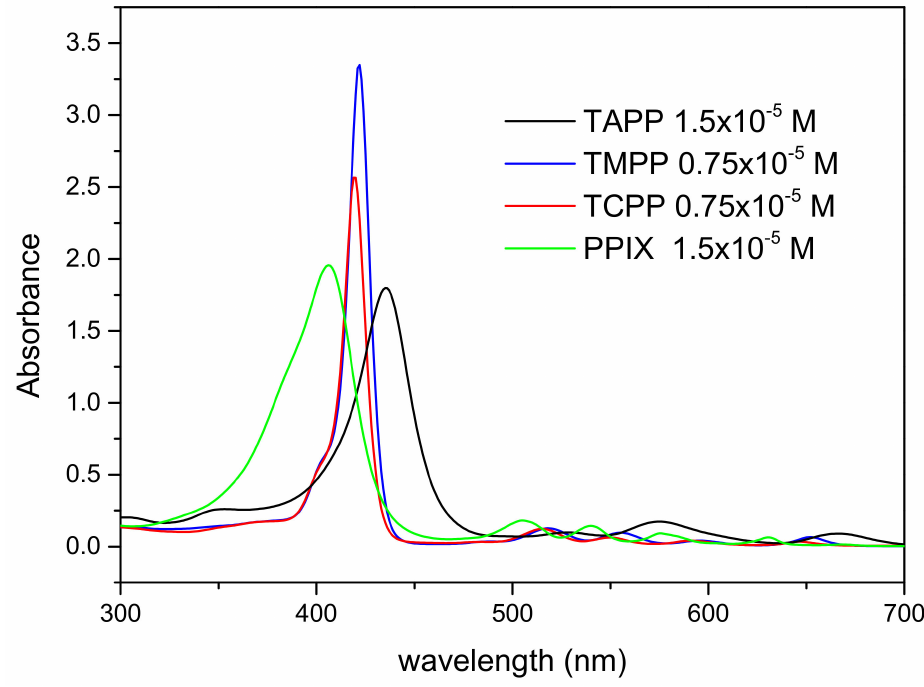
Figure 2. The absorption spectra of TAPP, TMPP, TCPP, and PPIX porphyrin solutions in